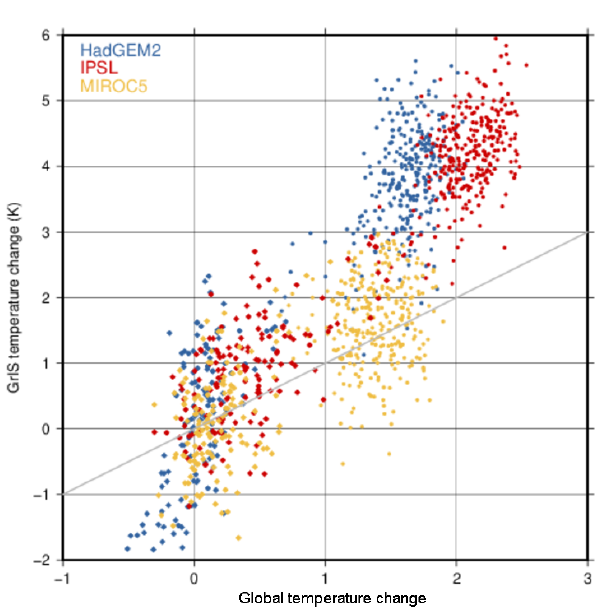
Figure 2. Scatter plot of annual mean near-surface air temper- ature change relative to pre-industrial levels over GrIS versus annual global mean near-surface air temperature change for the years 1861–2299. The gray line is the identity